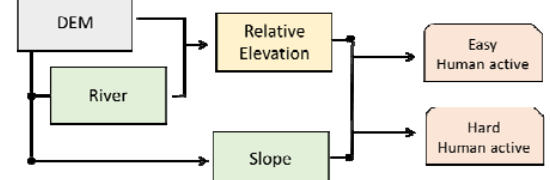
Figure 1. Identification of the area accessible to human activities using DEM